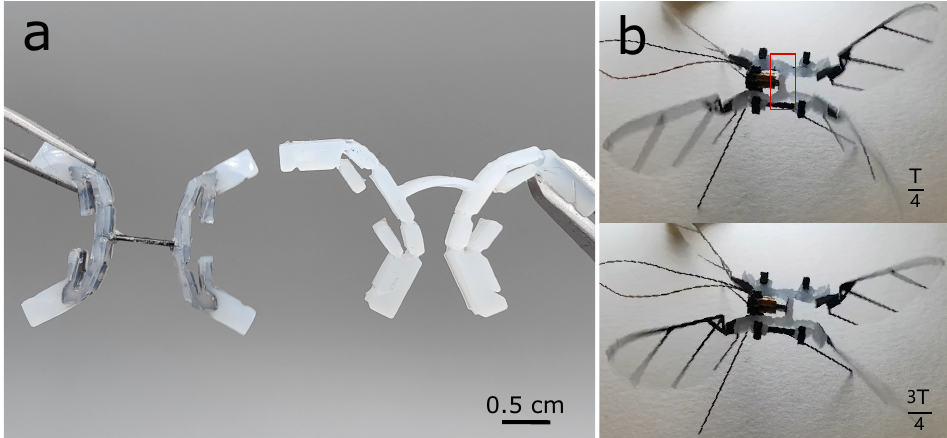
Figure 4. Comparison between a silicone transmission with internal skeleton ( a ), and a transmission made of just silicone ( b ). Silicone transmission deforms under the self-weight of the structure. ( b ) Example of dynamic deformation of silicone transmission without internal skeleton. The red box in the top image shows the actuator causing the transmission input to deform and undermine the stroke performance.